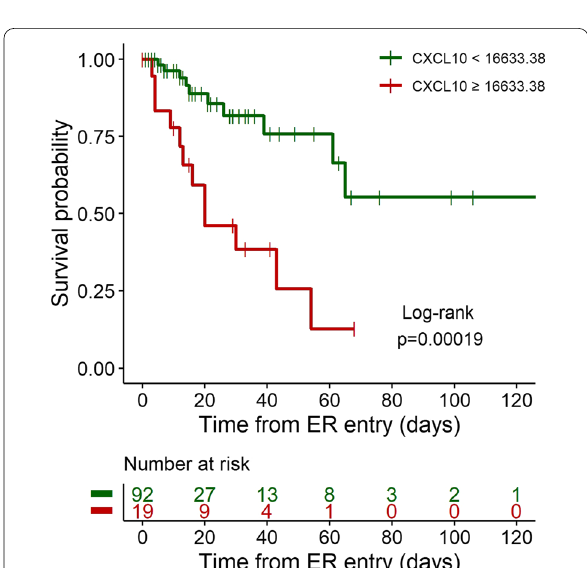
Fig. 4 Kaplan–Meier curves of overall survival and logrank test for comparing the two groups obtained from the decision tree analysis predicting the death for CXCL10 levels higher or lower than 16,633 pg/mL